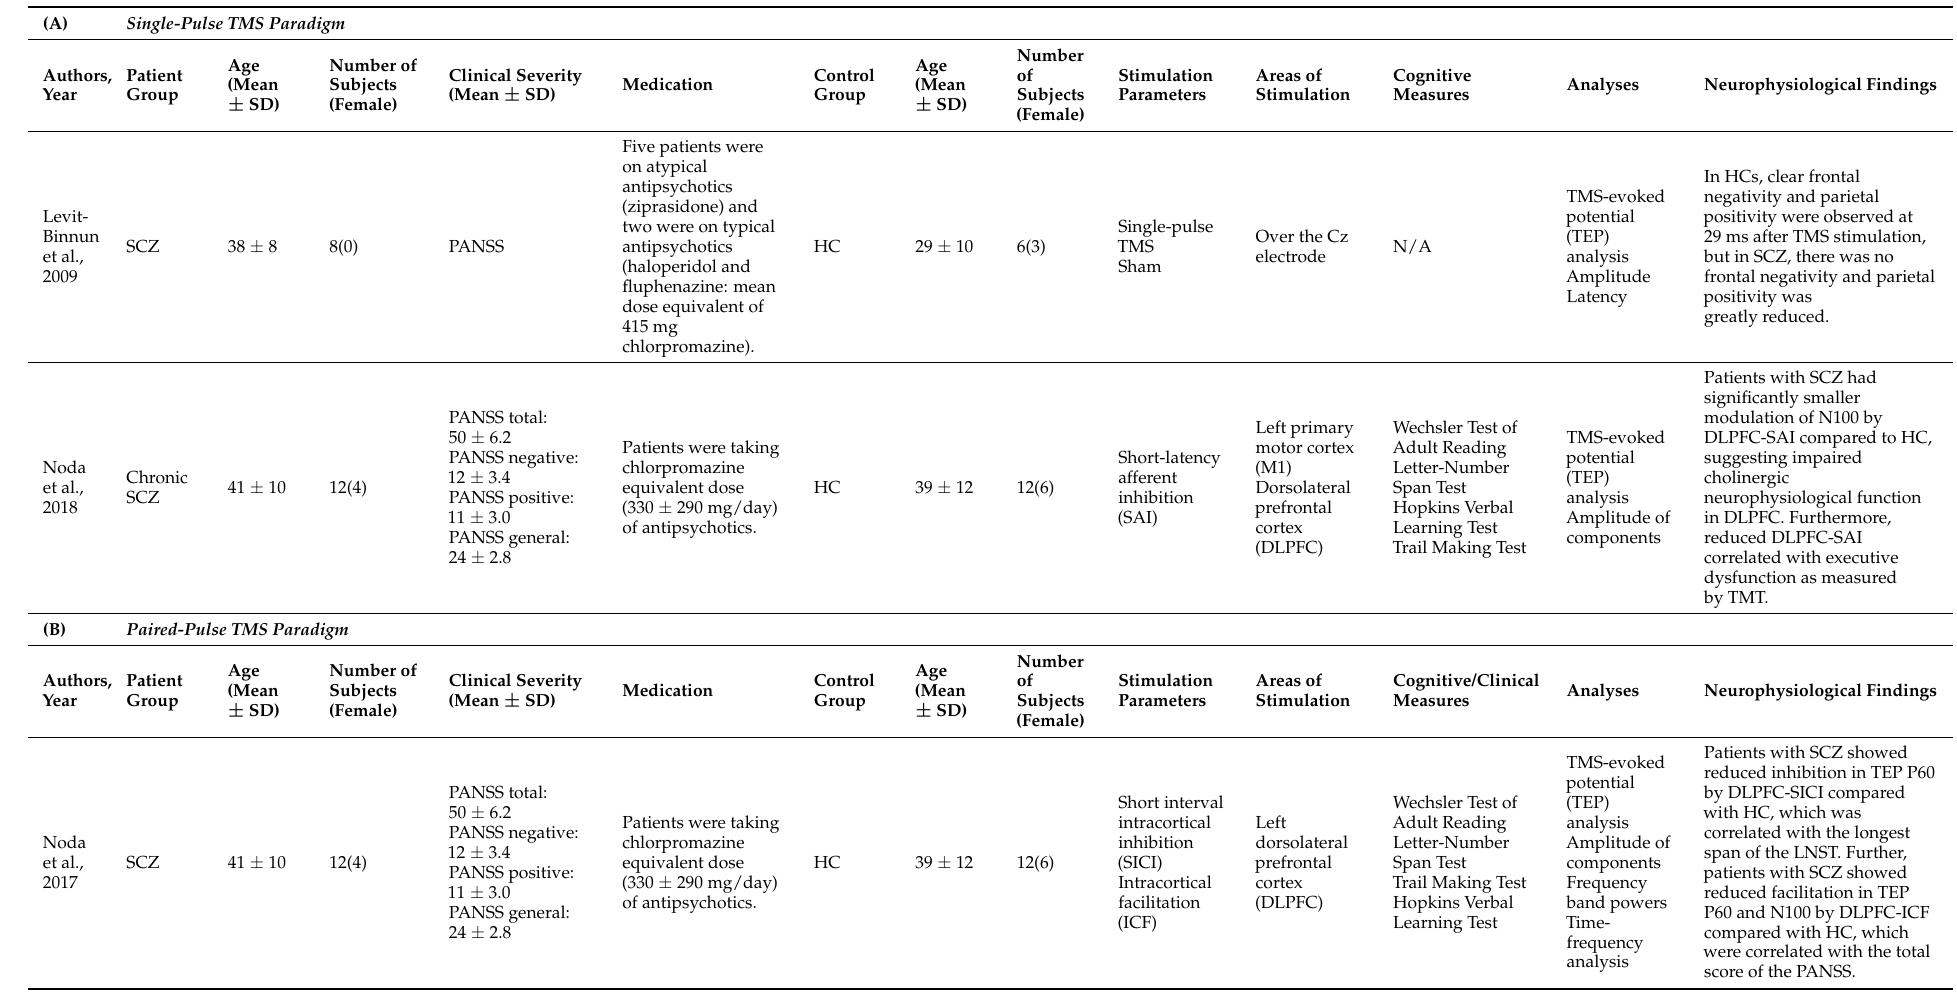
Table 1. TMS-evoked potentials (TEP)